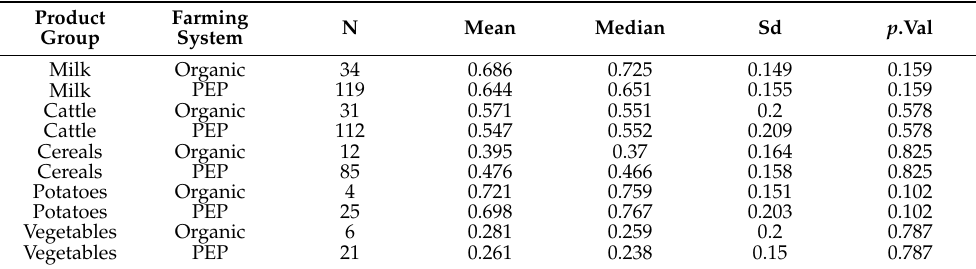
Table A9. Summary environmental efficiency scores proof of ecological performance (PEP) and Organic farming. The column “ p .val” shows the p -value from an